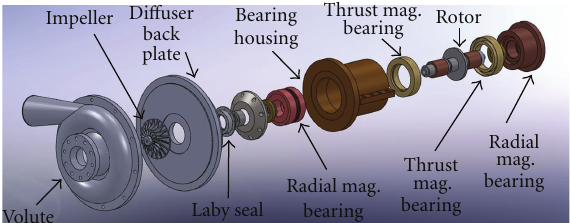
Figure 5: Exploded view of the compressor and magnetic bearing assembly.